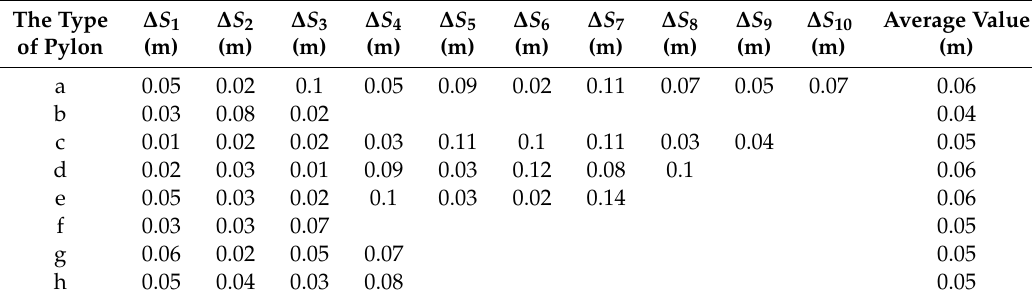
Table 9. The result of precision verification about pylon